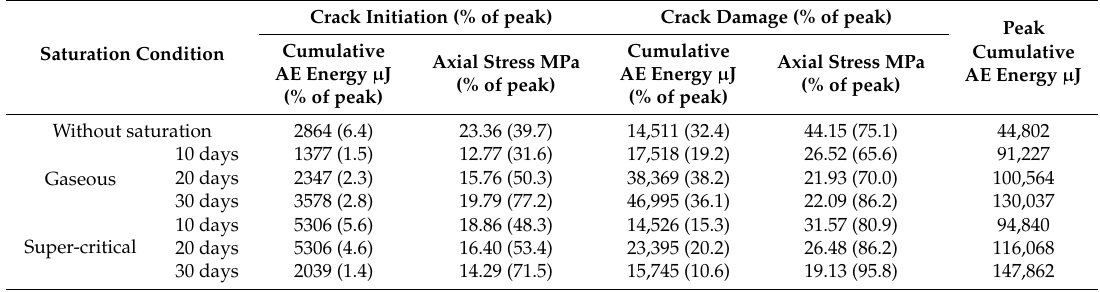
Table 6. Crack propagation threshold values of stress and cumulative energy release from AE results.